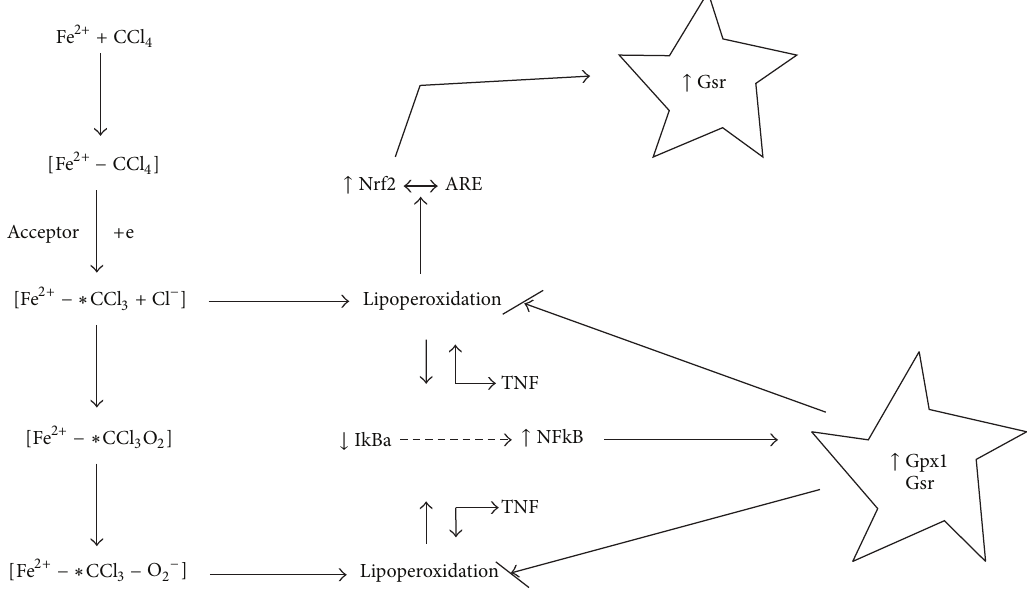
Figure 6: Hypothetical mechanism of activation of Gpx, Gsr by carbon